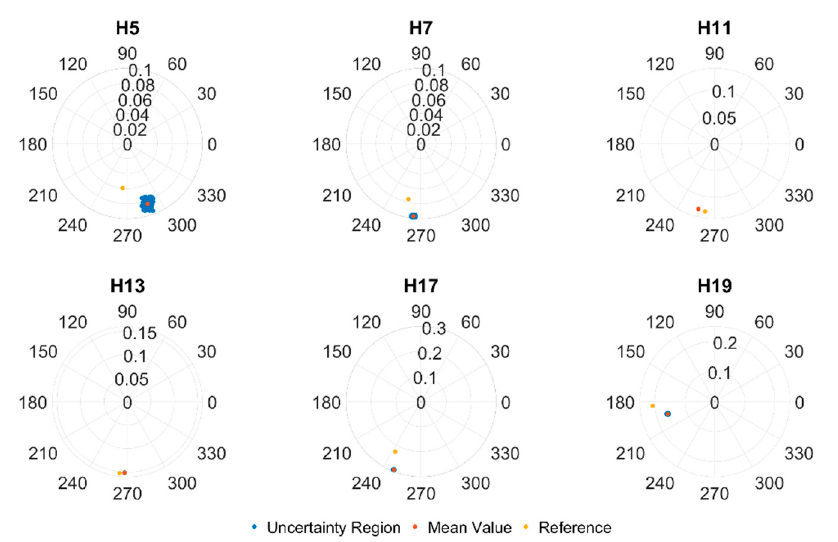
Figure 9. Compass plot of the customer side sub-grid impedance estimates (red dots) and the uncertainty